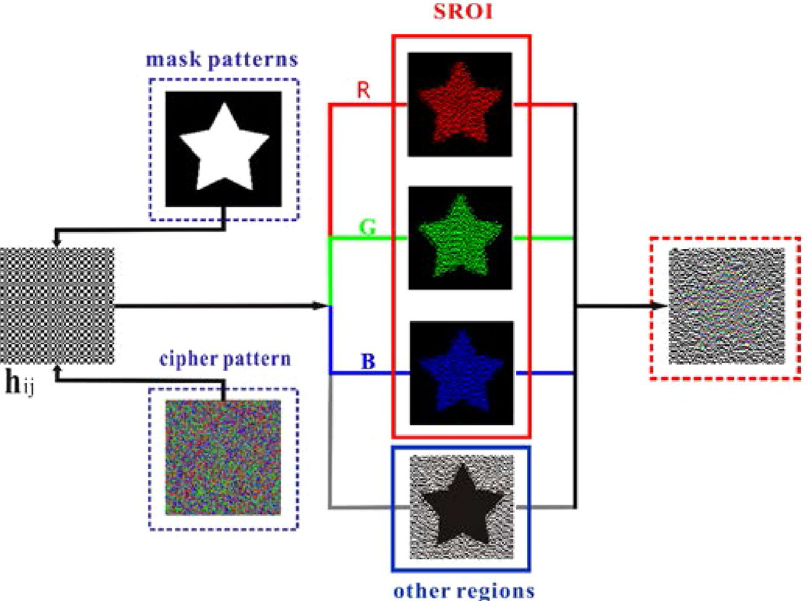
Figure 2. Schematic diagram of generating a composite color illumination pattern (64 × 64) in Experiment B.